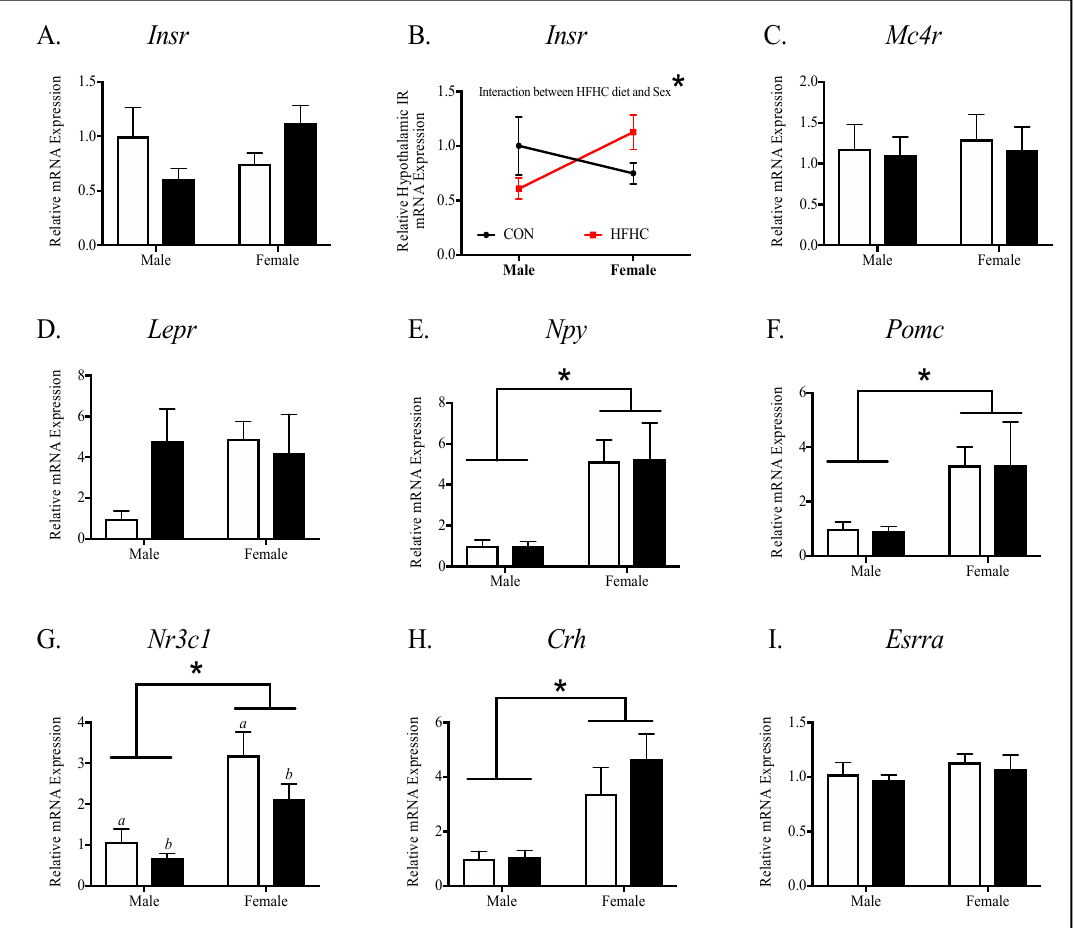
Figure 6. Offspring hypothalamic appetite signaling in peripubertal mice, following maternal HFHC-diet-induced obesity . Hypothalamic gene expression of insulin receptor (Panel A ), melanocortin 4 receptor (Panel C ), leptin receptor (Panel D ), neuropeptide-Y (gene transcript for hunger neuropeptide, Panel E ), proopiomelanocortin (gene transcript for satiety neuropeptide, Panel F ), glucocorticoid receptor (Panel G ), corticotropin-releasing hormone (Panel H ), and estrogen receptor alpha (Panel I ) were measured in fasted offspring, following weaning from CON and HFHC dams. There were no significant differences between CON and HFHC groups in the male or female offspring studied separately. There was an interaction between diet and sex in insulin receptor (Panel B ) such that males had a lower insulin receptor expression and the females had higher insulin receptor expression, when exposed to maternal HFHC diet (Panel B , p = 0.03). The HFHC offspring had a lower glucocorticoid receptor expression (Panel C , p = 0.05) compared to the CON offspring. The female offspring had a higher glucocorticoid receptor (Panel C , p < 0.0001), NPY (Panel D , p < 0.001), POMC (Panel E , p = 0.001), and CRH (Panel F , p = 0.004), compared to the male offspring. Results are expressed as mean ± SEM. CON—offspring born to dams maintained on control diet; HFHC—offspring born to dams maintained on high-fat–high-carbohydrate diet; black line (Panel B ) represents maternal CON-diet-exposed offspring; red line (Panel B ) represents maternal HFHC-diet-exposed offspring. NPY—neuropeptide-Y; POMC—proopiomelanocortin; CRH—corticotropin-releasing hormone. Open bars represent CON offspring; closed bars represent HFHC offspring; unpaired t -test or two-way ANOVA, followed by post-hoc Tukey’s HSD, n = 7–13/group, vs. offspring born to dams consuming same diet (diet effect), vs. male offspring born to dams consuming different diets (sex effect); * p < 0.05, p values > 0.1 were recorded as non-significant (NS).